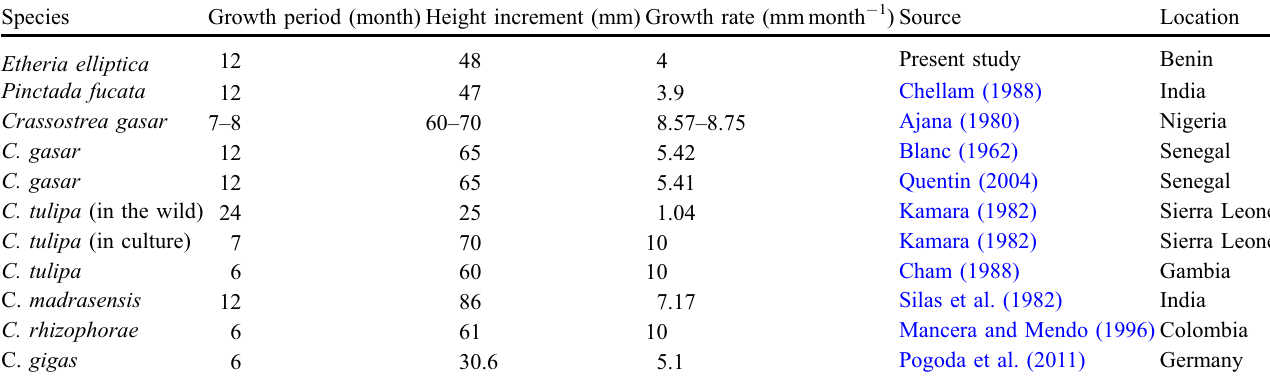
Table 3. Growth rate, height increments and growth period of E. elliptica in the Pendjari River compared to mangrove Crassostrea gasar oysters and other bivalves in the